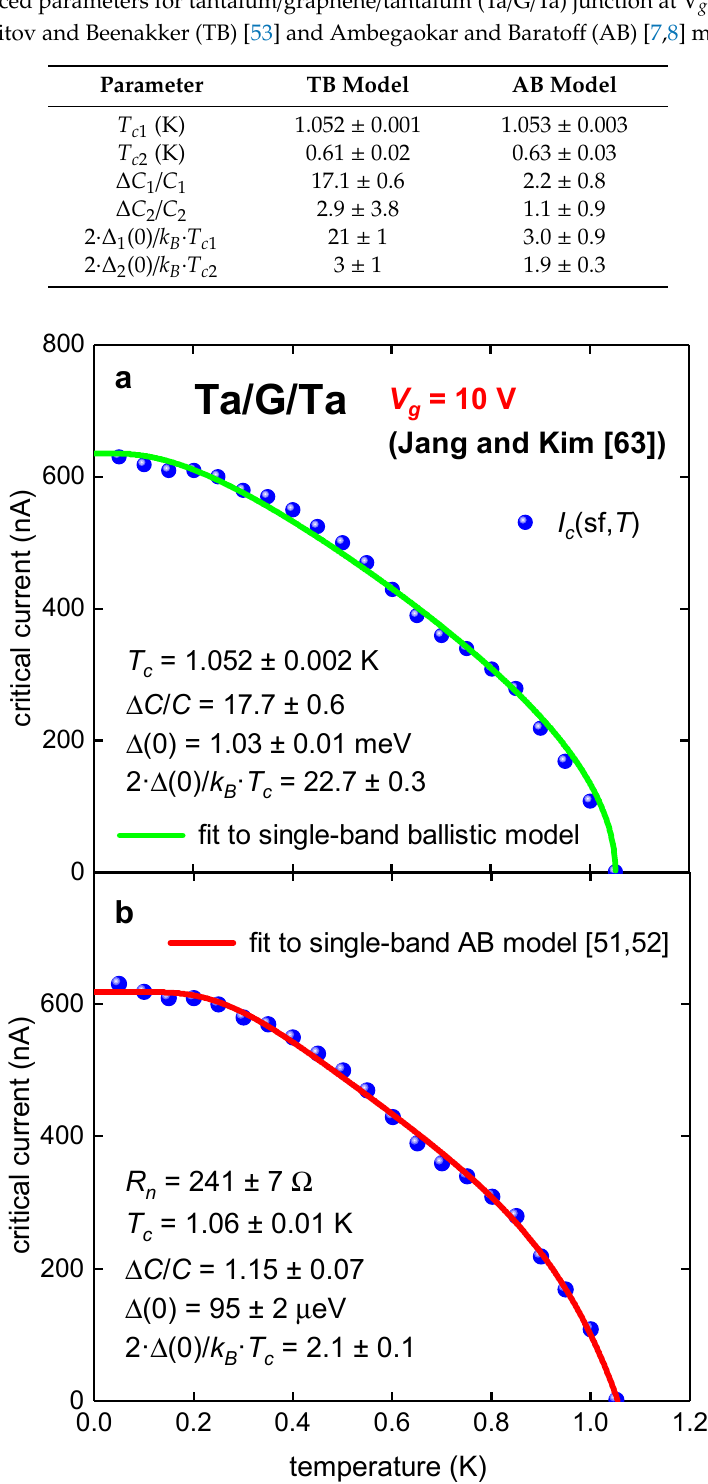
Figure 1. Experimental I c (sf , T ) for tantalum / graphene / tantalum (Ta / G / Ta) junction (Device 1) at gate voltage of V g = 10 V [63] and data fits to single-band ballistic model (Equation (7), Panel a) and single-band modified AB model (Equation (4), Panel b) ( a ) Ballistic model. fit quality is R = 0.9948; ( b ) modified AB model [51,52] fit quality is R = 0.9980.